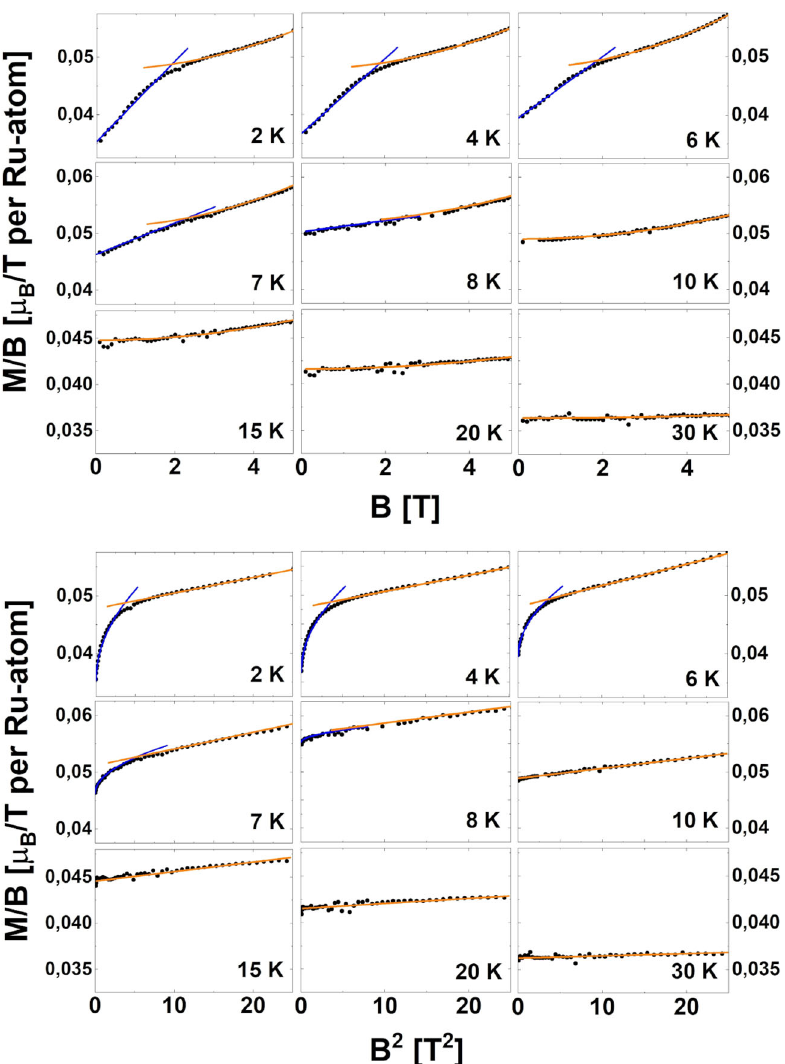
Fig. 2 Magnetization isotherms. The top set of nine panels show the ratio of the measured magnetization, M , to the magnetic fi eld, B , in α -RuCl 3 (with B up to 5 T ∥ a -axis) plotted against B . Such a plot provides the quadratic nonlinear susceptibility, χ 2 , via the slope of the blue straight lines on the low fi eld side. Since at the high fi eld end ( B > 3 T) the response is better fi t with a cubic term χ 3 , we show in the nine panels on the bottom a similar plot but with B 2 on the abscissa and the fi ts in orange straight lines. It is clear from these panels that χ 3 when B ∥ a -axis is positive over a wide temperature range, while χ 2 vanishes for T > T N